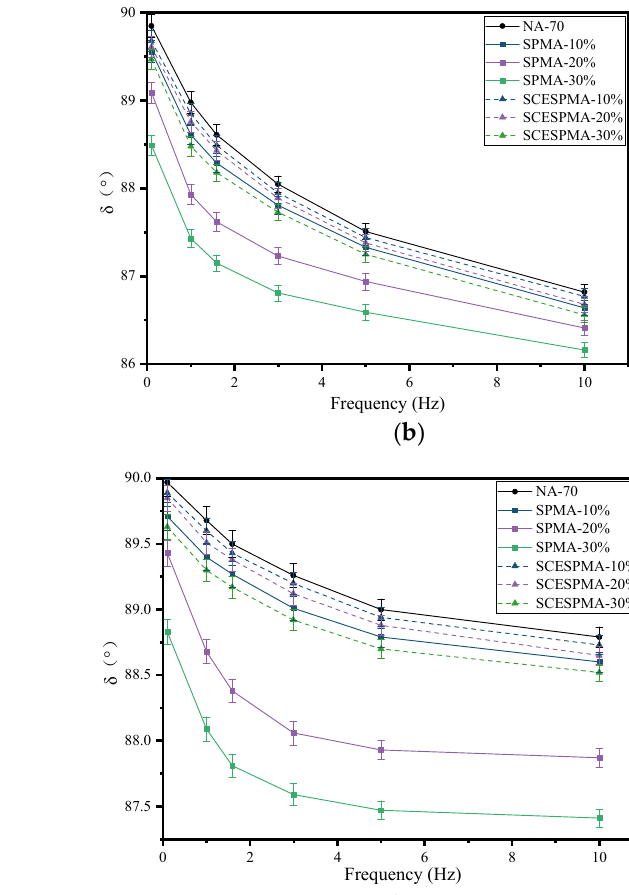
Figure 9. Relationship among G * and frequency of SPMA and SCESPMA at different temperatures.